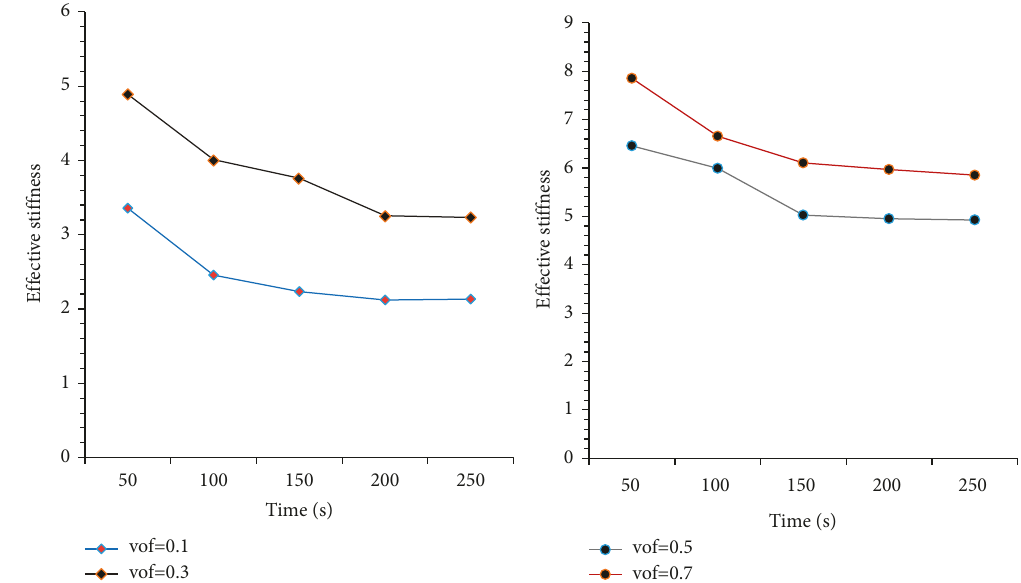
Figure 9: Variation law of effective stress relaxation stiffness under different volume